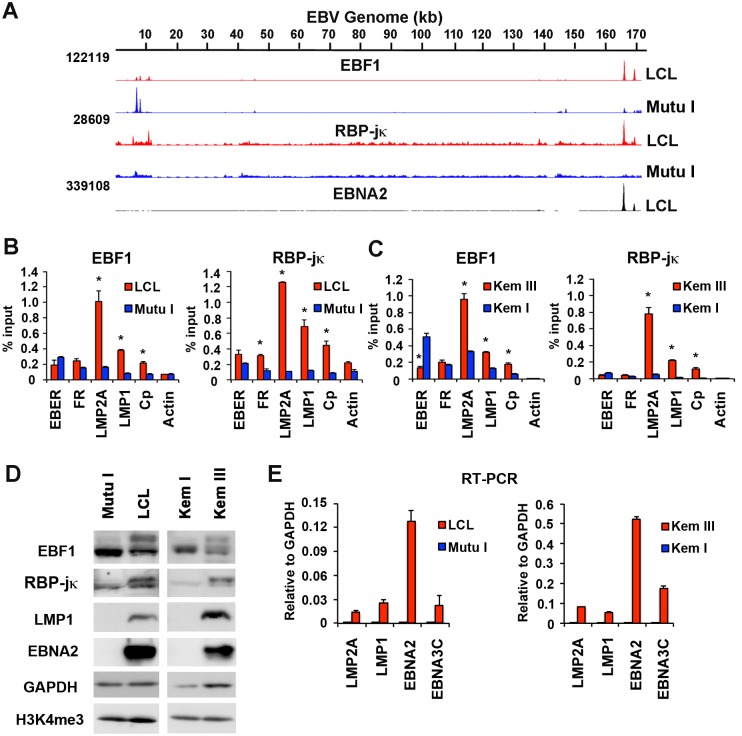
Differential binding of transcription factors on EBV genomes in type I and type III latency.
(A) ChIP-Seq tracks mapped to EBV genome in LCL (red) or Mutu I (blue) for EBF1 or RBP-jκ as indicated. EBNA2 ChIP-Seq for LCL (black). Y-axis represent raw read counts. (B) ChIP-qPCR for EBF1 or RBP-jκ in LCL (red) or Mutu I (blue) at various EBV genome regulatory regions as indicated and Actin genomic region as negative control. (C) Same as in B, except for isogenic EBV positive BL cells Kem III (red) or Kem I (blue). Asterisk indicates p < 0.05. (D) Western blot of Mutu I, LCL, Kem I, and Kem III probed with antibody to EBF1, RBP-jκ, LMP1, and EBNA2, with cellular loading controls for GAPDH and H3K4me3, as indicated. (E) RT-qPCR for EBV type III gene expression in LCL or Mutu I (left panel) or Kem I and Kem III (right panel).